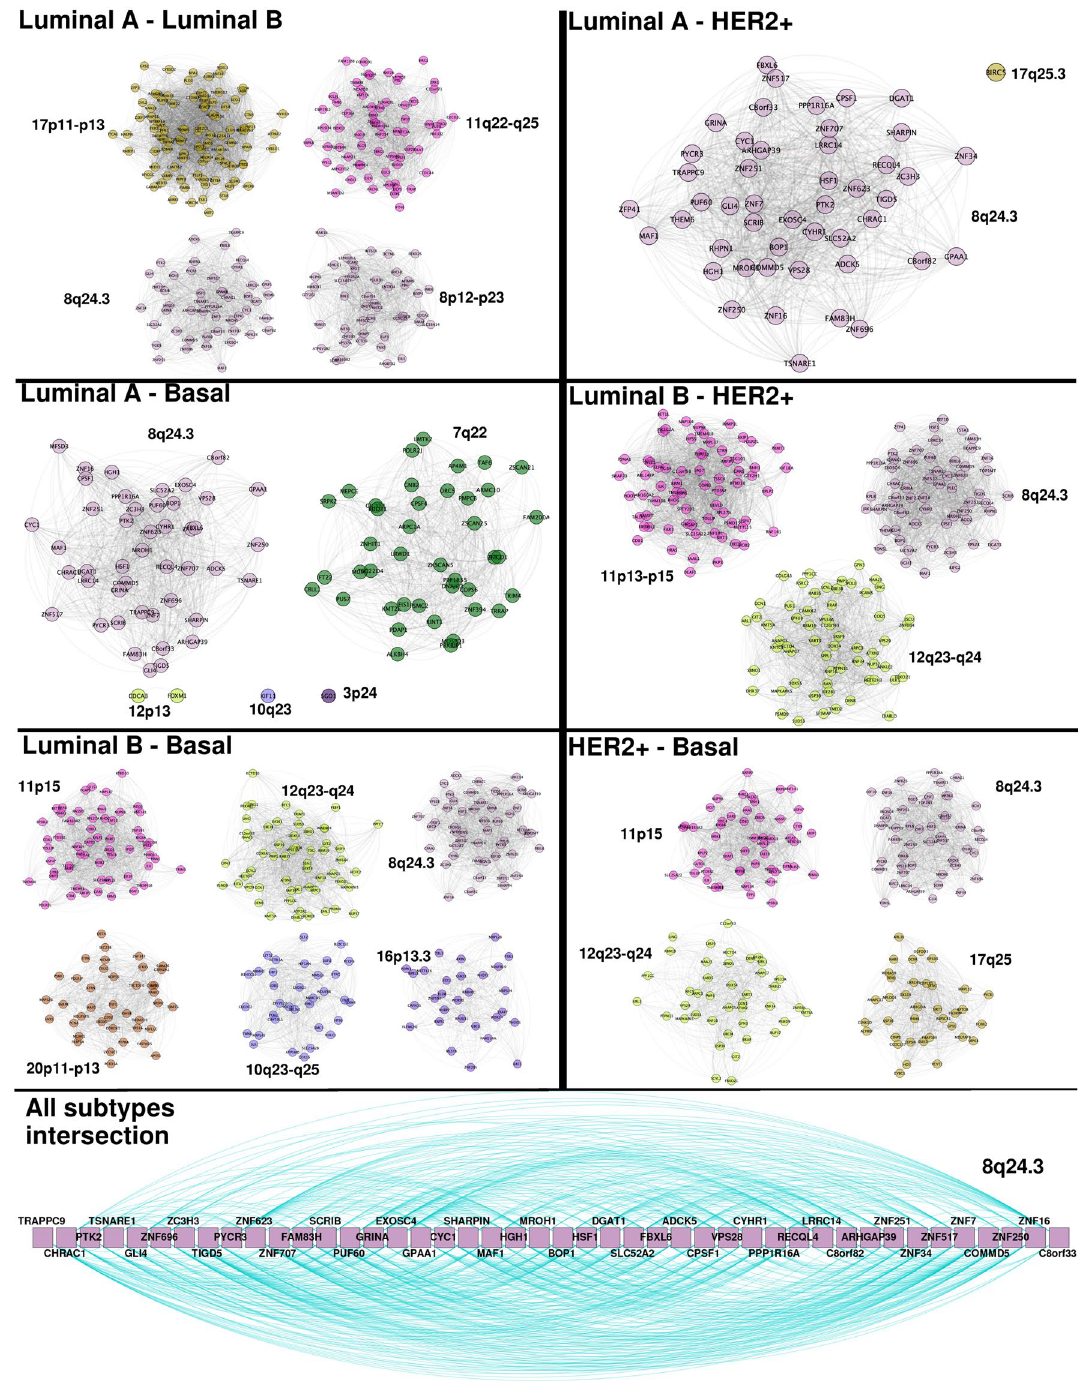
Figure 10. Breast cancer 30-core networks intersections. In each image, edge intersection for two different breast cancer subtypes is depicted. The bottom image shows the intersection of the four phenotypes. It is important to remark that intersection is at the interactions level. The only set of adges that is shared among the four 30-core network of breast cancer subtypes is composed of genes in the Chr8q24.3